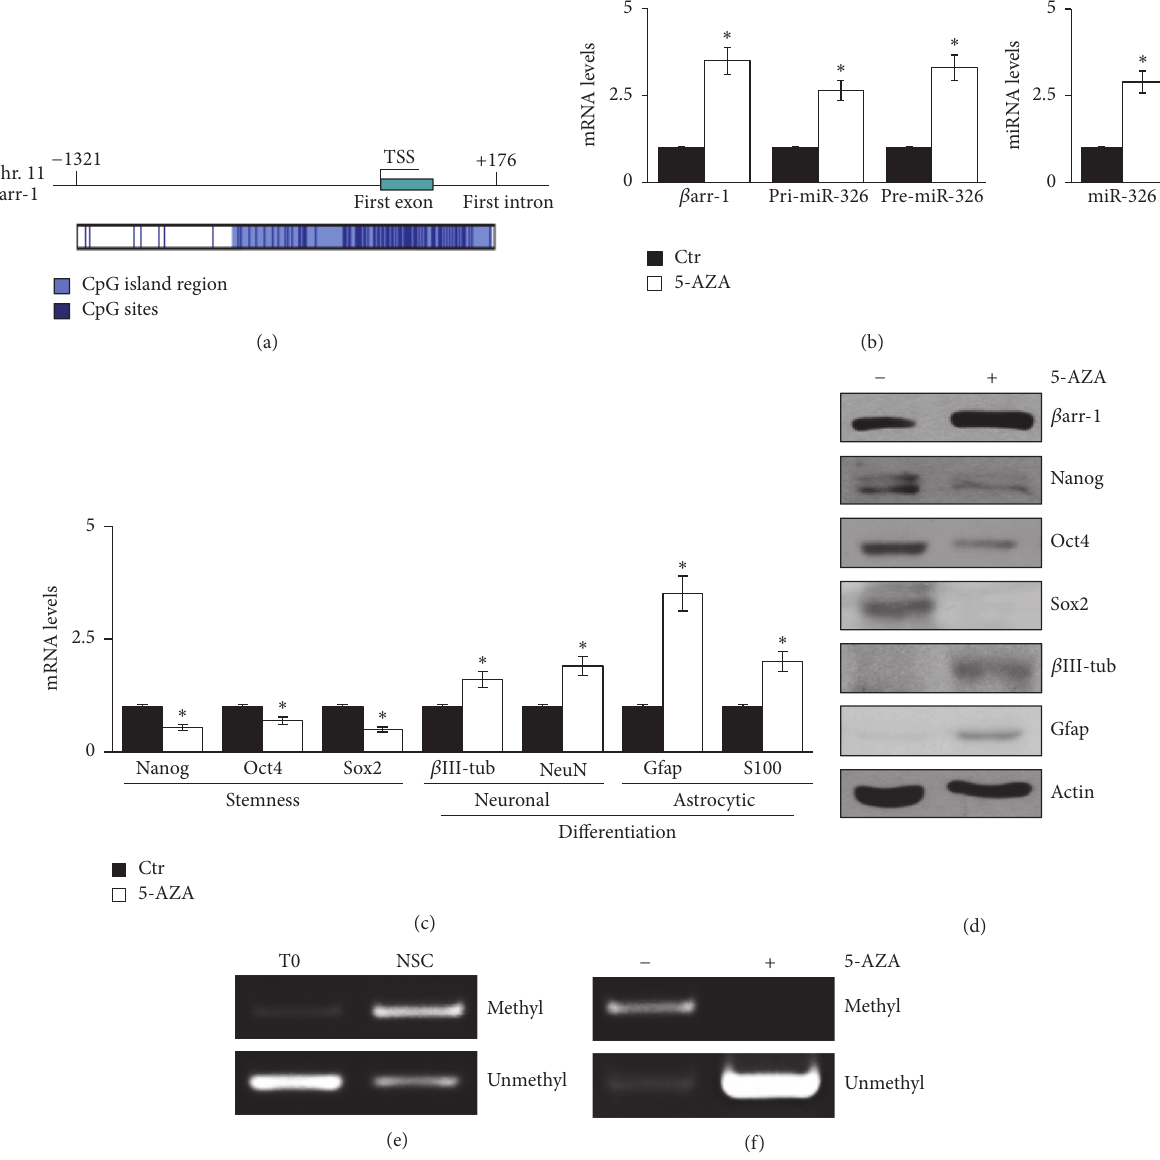
Figure 3: CpG island methylation of miR-326/ 𝛽 arr-1 regulatory sequence controls 𝛽 arr-1 and miR-326 expression. (a) Schematic representation of mouse miR-326/ 𝛽 arr-1 regulatory regions, highlighting the CpG islands regions (light blue) and the CpG islands sites (blue) derived from DBCAT software. (b) mRNA expression levels of 𝛽 arr-1 and precursor forms of miR-326 and miR-326 expression levels in NSCs after4daysof5-azacytidine(5-AZA)treatment.Dataaremeans ± SDfrom3independentexperiments. ∗ 𝑝 < 0.05 .((c)-(d))mRNAexpression levels (c) and Western blot analysis (d) of endogenous 𝛽 arr-1, stemness markers (Nanog, Oct4, and Sox2), and differentiation markers ( 𝛽 III- tub and Gfap) after 4 days of 5-azacytidine (5-AZA) treatment in NSCs. Actin as LC. Data are means ± SD from 3 independent experiments. ∗ 𝑝 < 0.05 .(e)MethylationspecificPCRofthescreenedregioninNSCscomparedtothestartingbulkpopulation(T0).(f)Methylationspecific PCR of the screened region in NSCs after 5-AZA treatment. ((e) and (f)) Data are representative images from 3 independent